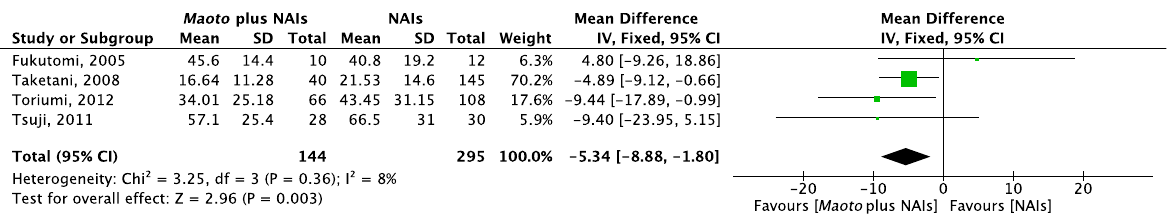
Fig. 3 Forest plot of fever duration after drug administration: maoto plus neuraminidase inhibitors (NAIs) vs. NAIs alone. The combination of maoto plus NAIs is superior to NAIs alone ( P = 0.002, weighted mean difference = − 5.41 h, I 2 = 0%). The heterogeneity is not significant (P > 0.1,